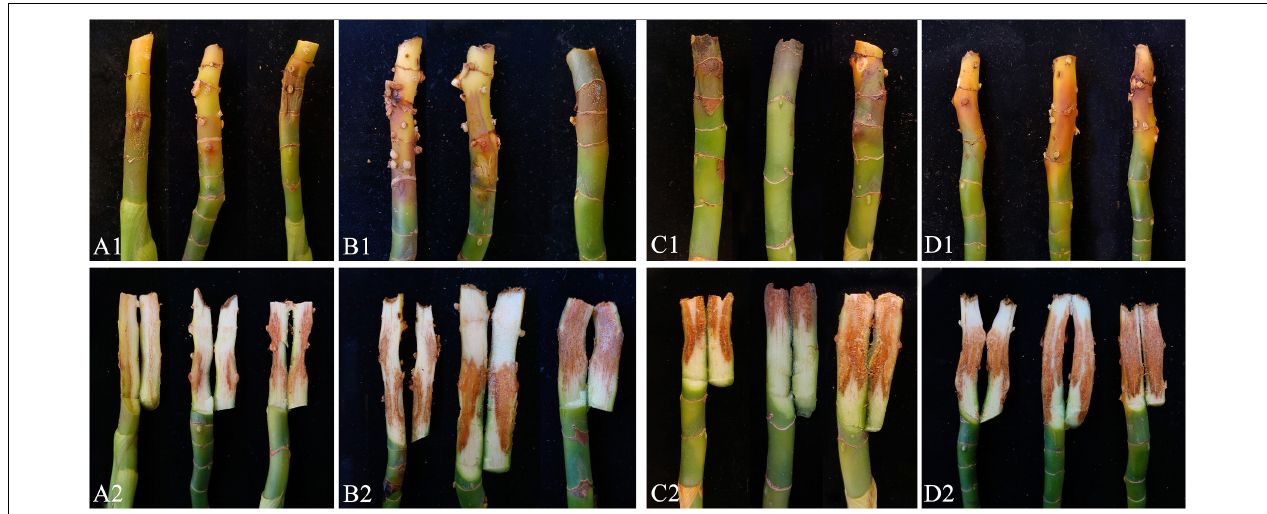
FIGURE 8 | Inoculation test results of Alocasia modestum with and without physical injury. (A1,A2) Inoculation without physical injury using F. aglaonematis only. (B1,B2) Inoculation with physical injury using F. aglaonematis only. (C1,C2) Inoculation without physical injury using both F. aglaonematis and F. elaeidis. (D1,D2) Inoculation with physical injury using both F. aglaonematis and F. elaeidis